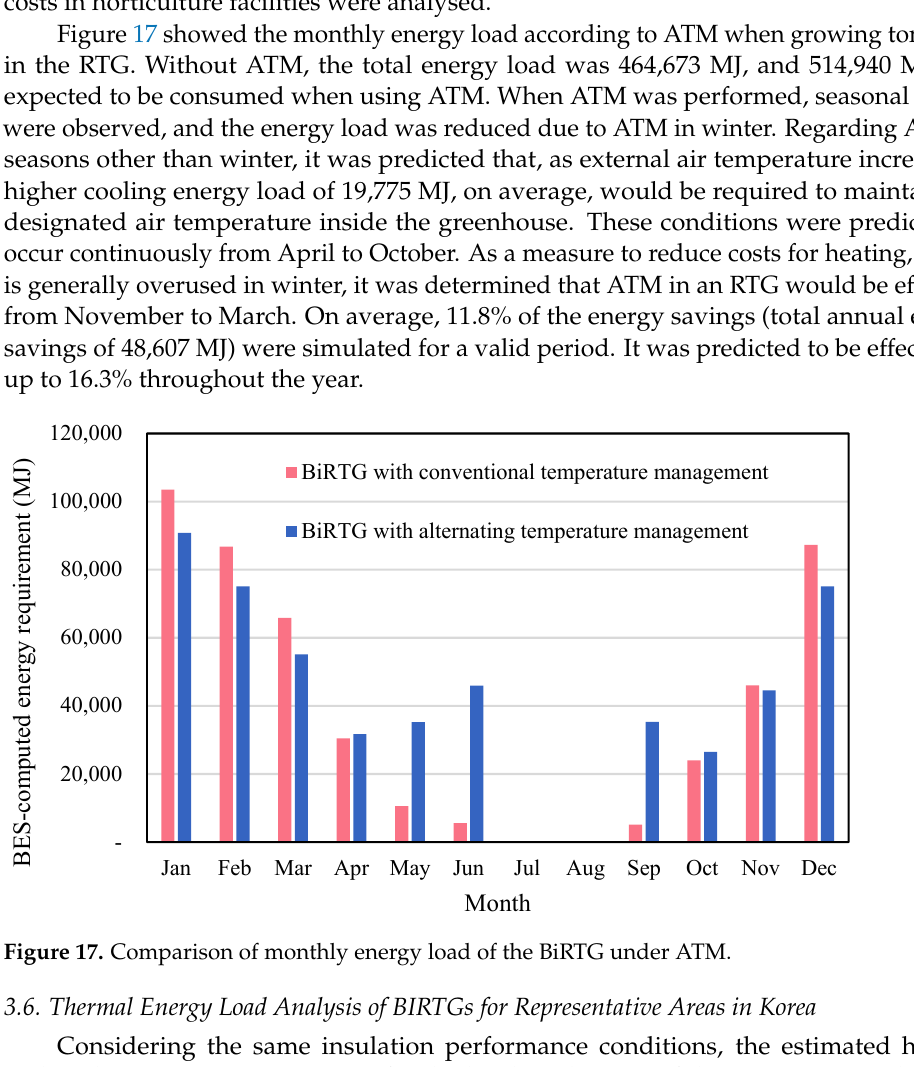
Figure 18. Analysis of monthly energy load after installations of BiRTGs in representative regions of Korea (Seoul, Daejeon, Daegu, and Pusan). The energy load tended to increase during winter when the ambient air temperature was low and during the change of seasons with a large daily air temperature difference. The energy load at low latitudes was relatively low compared to that at high latitudes. This was because latitude differences occurred in the southern and northern regions of Korea, resulting in differences in air temperature for each region. Comparing Seoul and